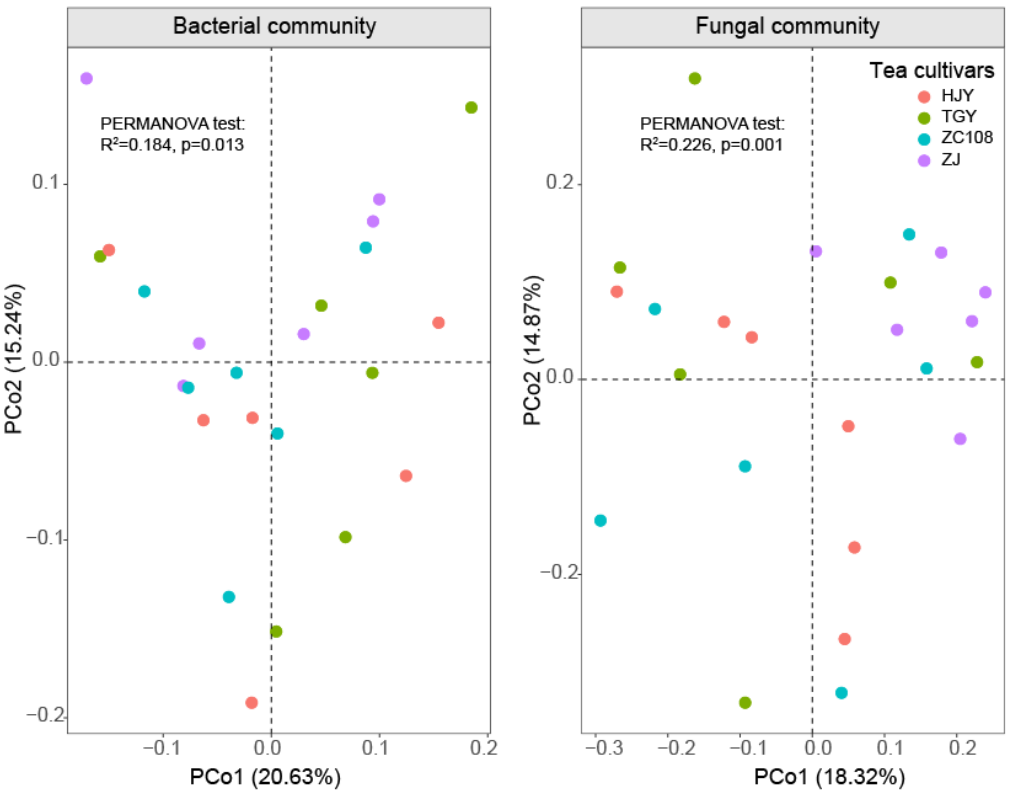
Figure 2. Venn diagram of bacterial ( a ) and fungal ( b ) OTUs in the soils with different tea cultivars.